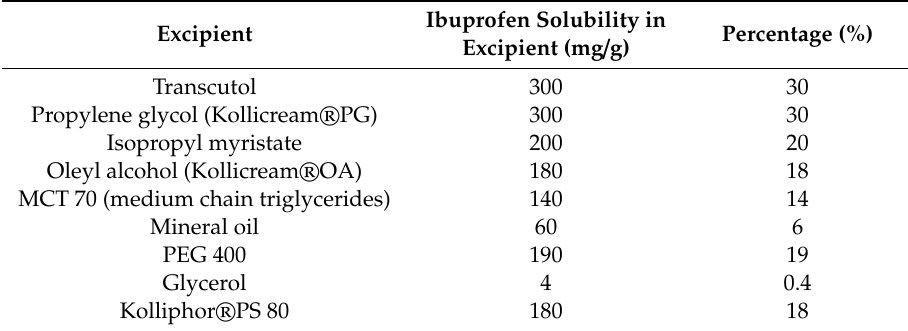
Table 4. Visual solubility of ibuprofen in solvents.